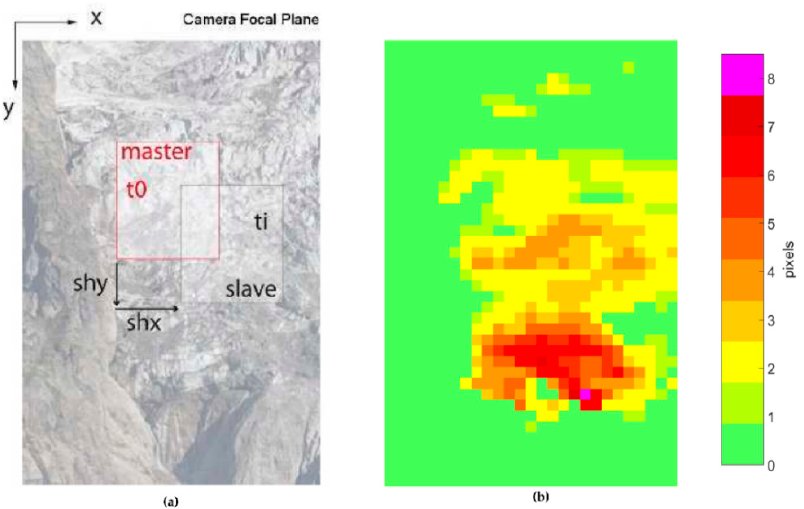
Figure 7. ( a ) Representation of the Pixel Offset iterative algorithm: the tile of the Master image is compared with the same tile of the Slave image. The procedure is applied to all the tiles. ( b ) Example of a result of the Pixel Offset algorithm with the vertical displacement between images computed in pixels.